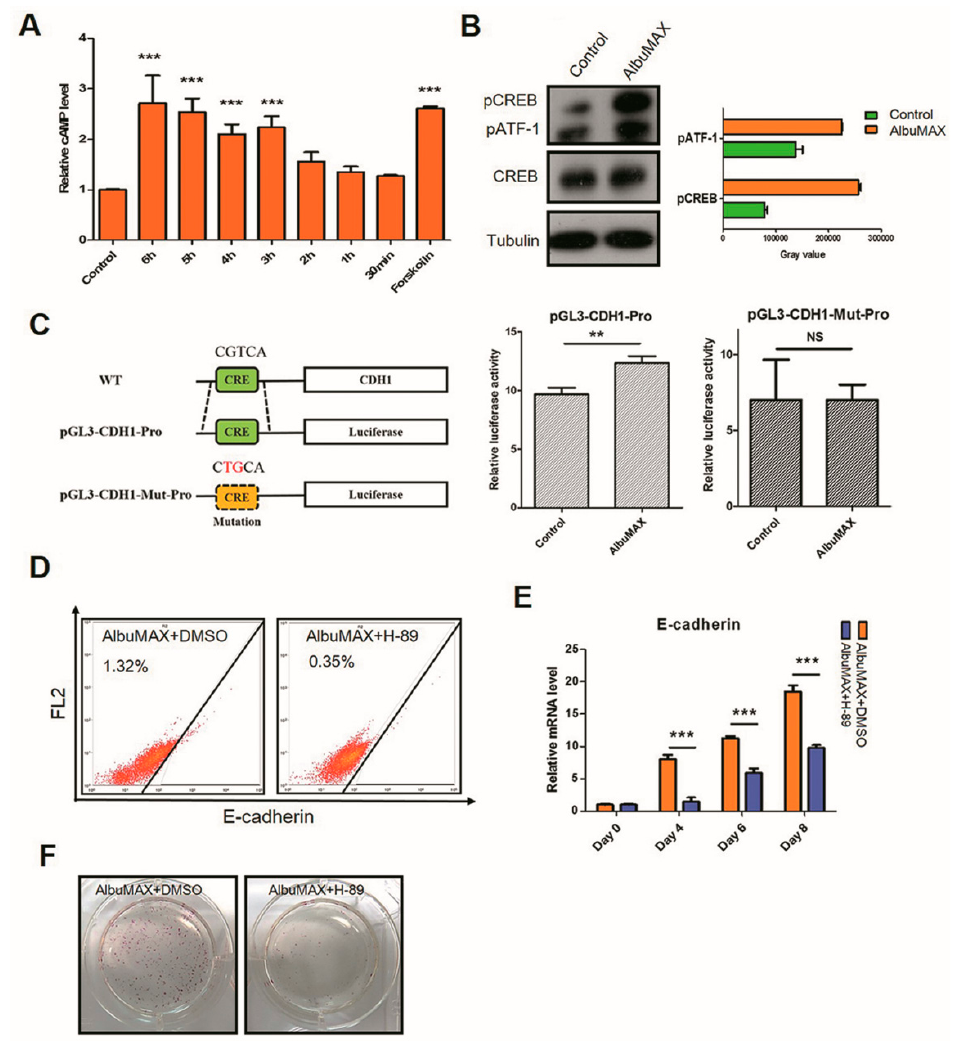
Figure 6. AlbuMAX enhances reprograming through cAMP/PKA signaling pathway. ( A ) Analysis of cAMP levels after AlbuMAX treatment at different time. The control was treated with 1% BSA for 30 min. The positive control group was treated with Forskolin (10 µ M) for 30 min. *** p < 0.001; ( B ) Western blot detected the phosphorylation of CREB and Activating transcription factor-1 (ATF-1); ( C ) Luciferase reporter and mutation reporter construction and luciferase activity assay. ** p < 0.01; ( D ) E-cadherin expression level analysis by flow cytometry; ( E ) Quantitative RT-PCR analyzed the expression of E-cadherin during reprogramming. Day 0, Day 4, Day 6 and Day 8 indicated the time that H-89 (20 µ M) was added. *** p < 0.001; ( F ) AP staining during reprogramming.